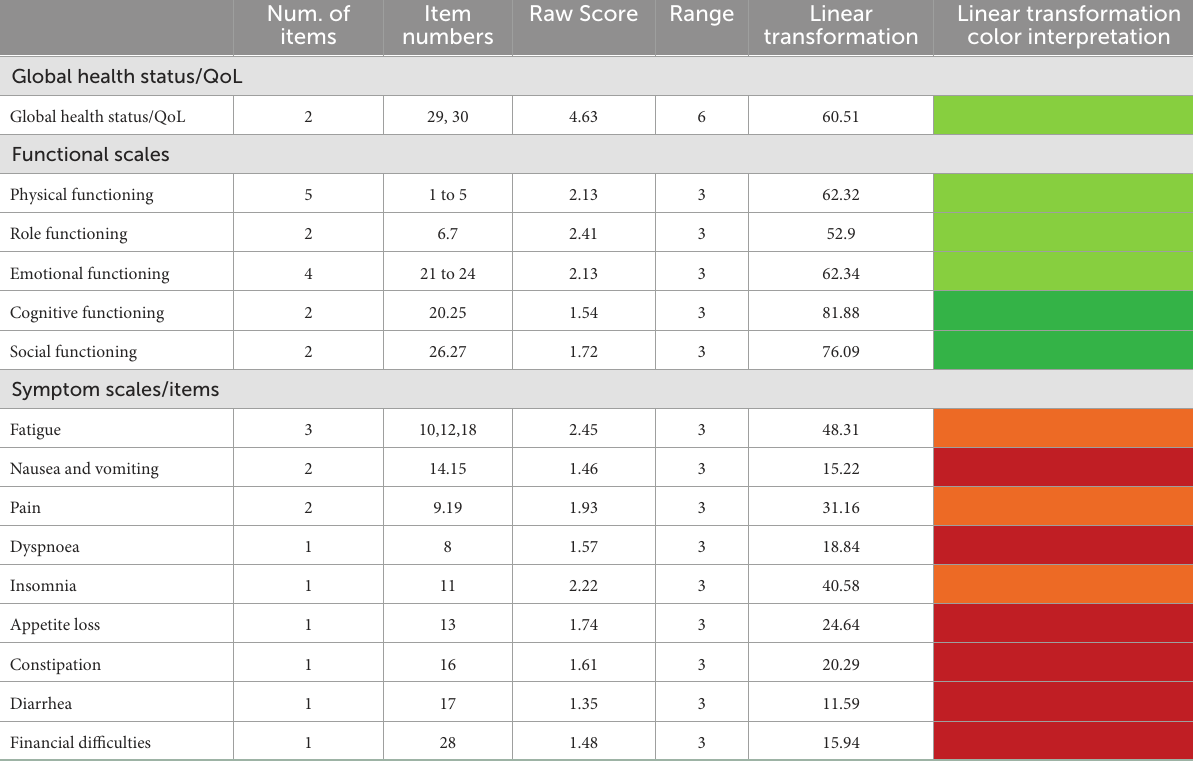
TABLE 1 Results of EORTC QLQ-C30 questionnaire.